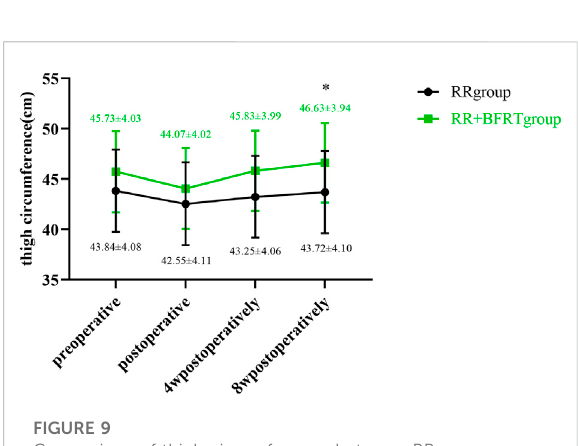
FIGURE 9 Comparison of thigh circumference between RR group and RR + BFRT group at different time points (cm). “ * ” indicates a signi fi cant change ( p < 0.05). Values are presented as mean ± SD. RR Group: routine rehabilitation group; RR + BFRT Group: routine rehabilitation + blood fl ow restriction training